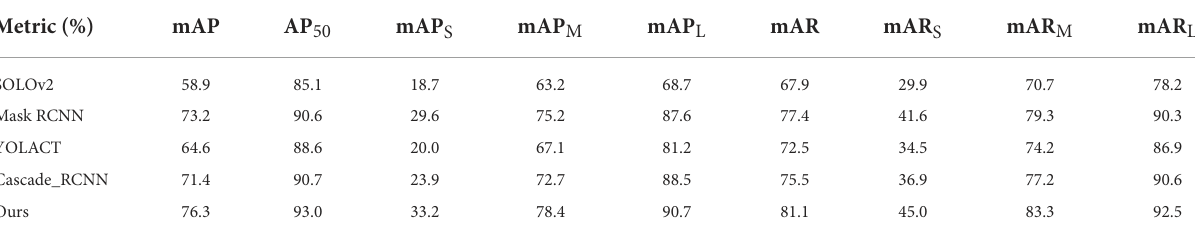
TABLE 4 Comparison of instance segmentation performance of five different